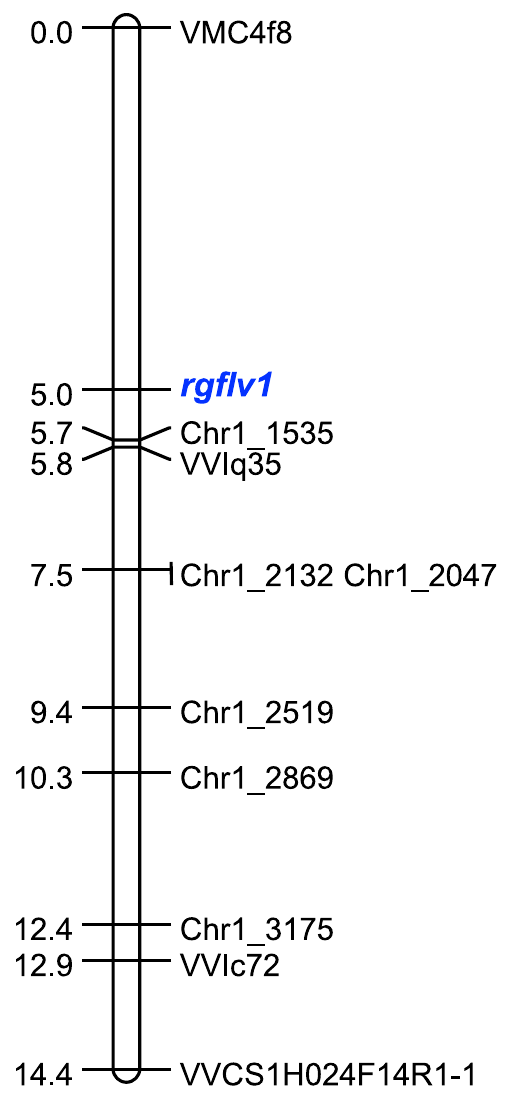
Fig. 5 Genetic map of the rg fl v1 locus. Ten SSR markers located on chromosome 1 and surrounding the rg fl v1 locus are represented. Scale on the left is in